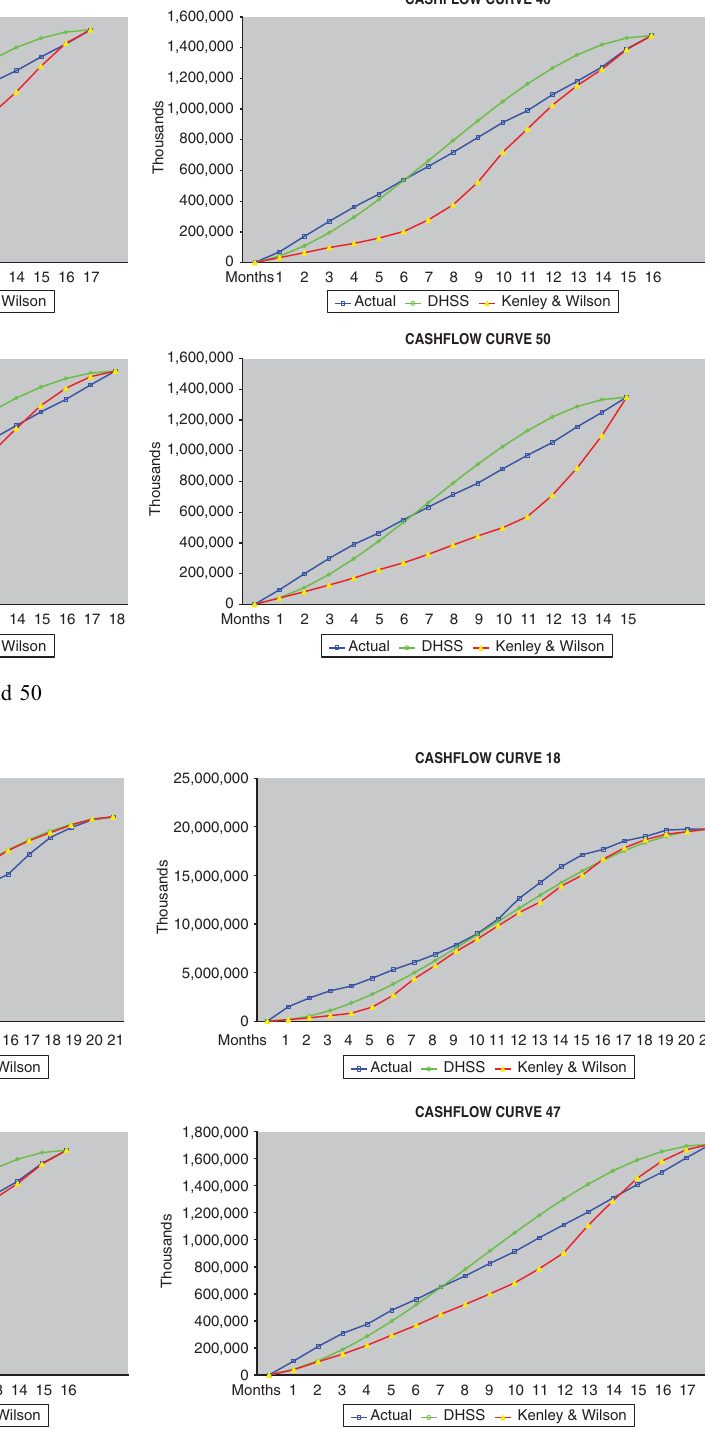
Fig. 3. Cash fl ow curves for projects 12, 18, 46 and